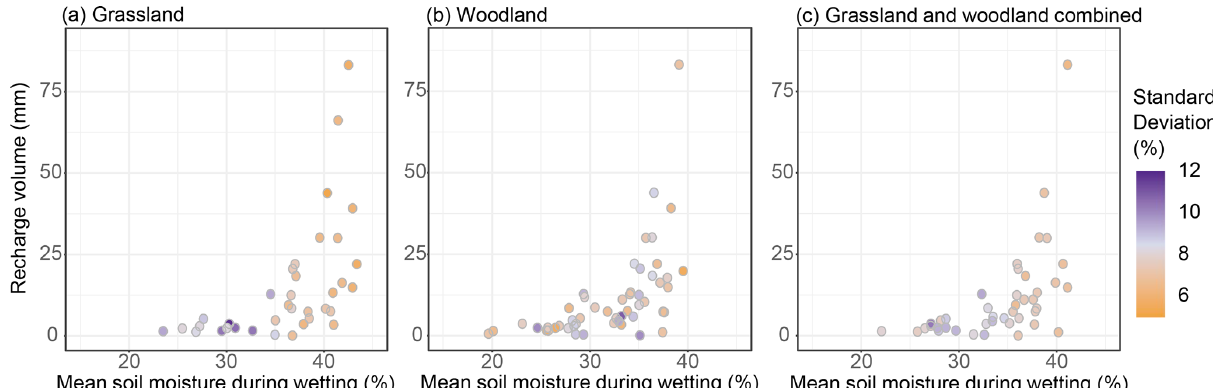
Figure 6. Relationship between recharge and mean soil moisture during the wetting period. Each data point corresponds to one selected event; the colour indicates the standard deviation of mean soil moisture during the wetting period caused by the variability within the grassland (a) , woodland (b) , and the combined areas (c)